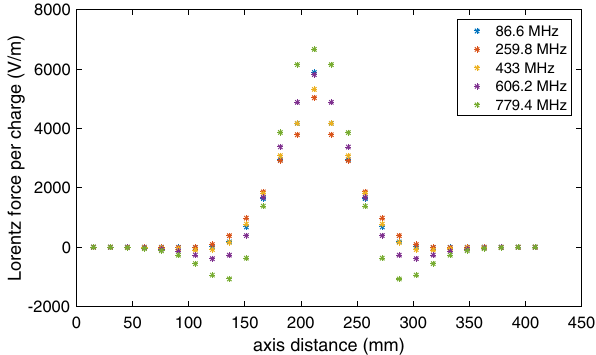
FIG. 13. The longitudinal field profile in a long kick model for the Lorentz force. The model consists of a series of 27 δ -function kicks separated by drift spaces. The envelope of the amplitudes is Gaussian.